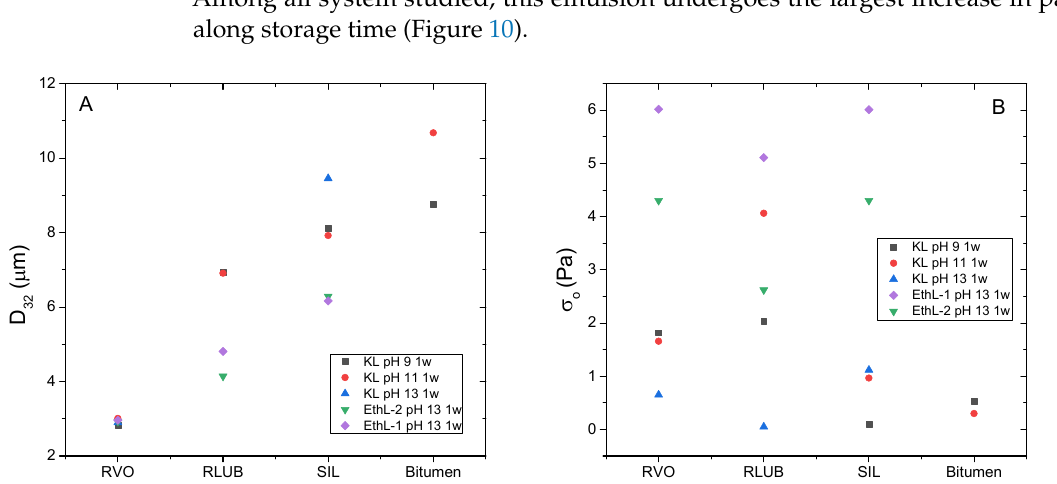
Figure 9. Sauter mean diameters ( A ) and yield stress values ( B ) of emulsions stabilized by bioethanol-derived and Kraft lignins formulated at different pH and stored for one week.